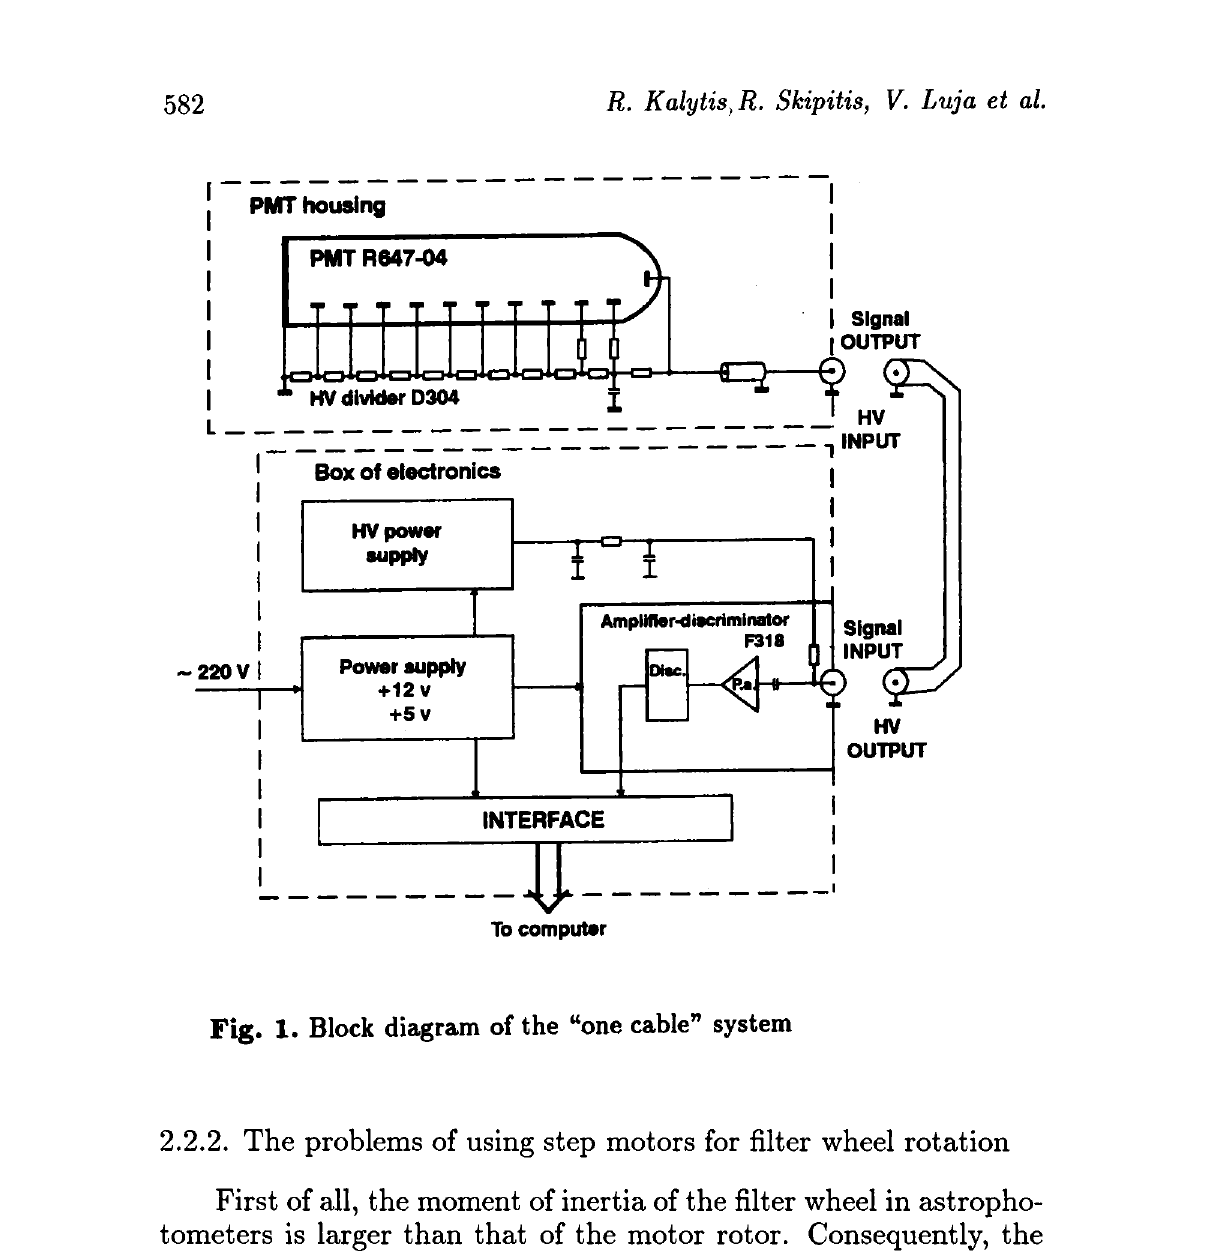
Fig. 1. Block diagram of the "one cable"